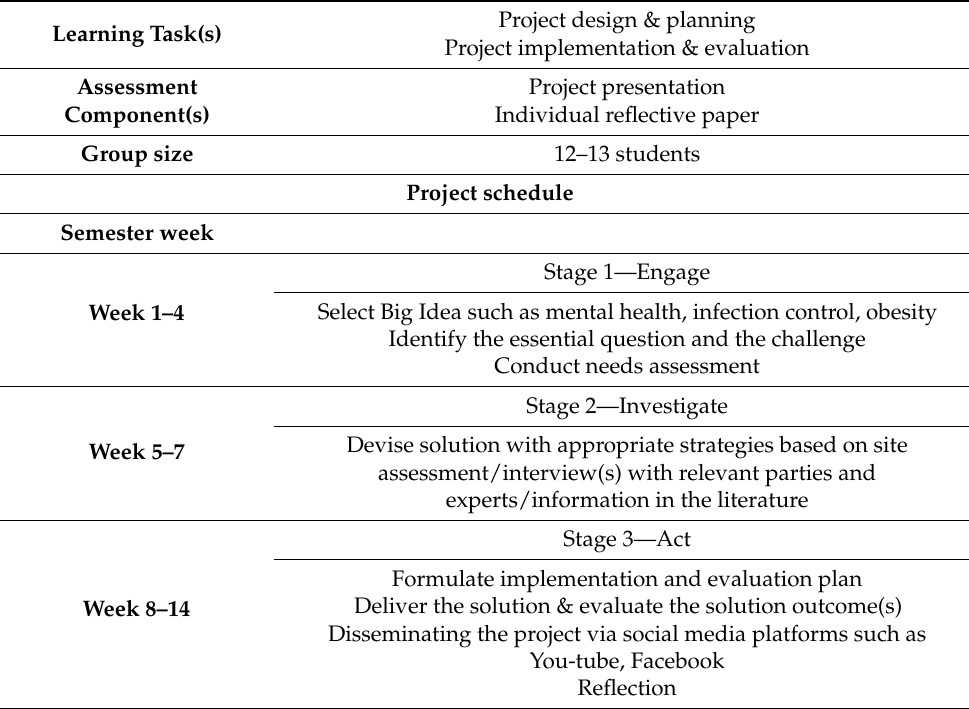
Table 1. Learning plan for group project in the public health course over the 14